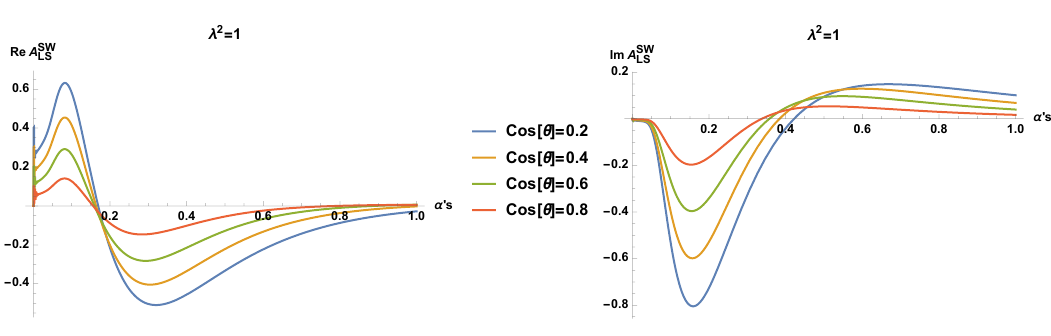
Figure 9 . Real and imaginary part of the LS amplitude in the hard wall background at different values of c for ∆ = 8 . θ ±